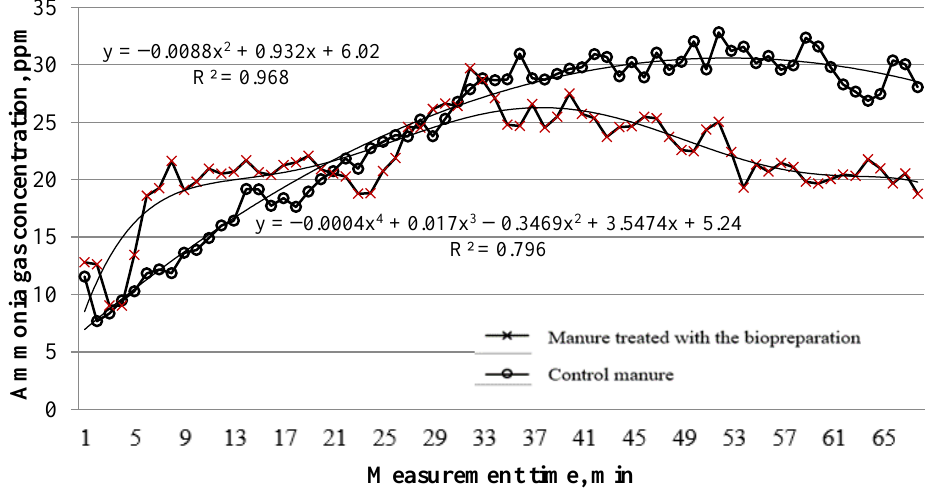
Figure 1. Ammonia concentration when fresh liquid cattle manure was mixed and homogenized with biopreparation or not (control) as measured in the wind tunnel up to 67 min.